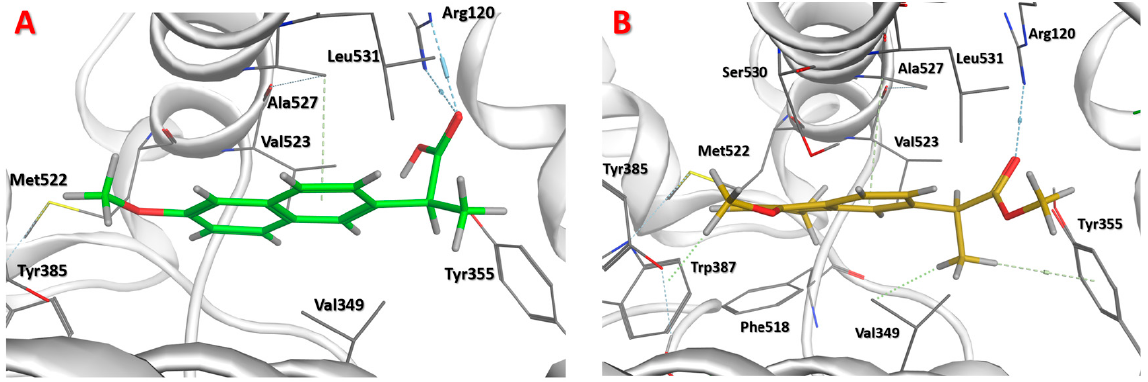
Figure 2. ( A ) Best docking pose of naproxen; ( B ) best docking pose of derivative 1.